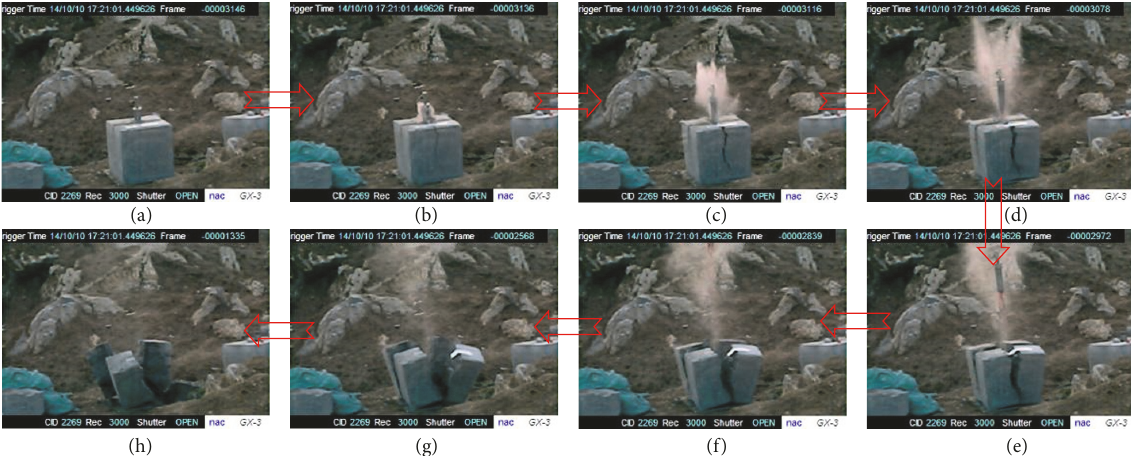
Figure 12: The pressured water coupling blasting process in the A2B2C1 case: (a) No. 3146; (b) No. 3136; (c) No. 3116; (d) No. 3078; (e) No. 2972; (f) No. 2839; (g) No. 2568; and (h) No. 1335